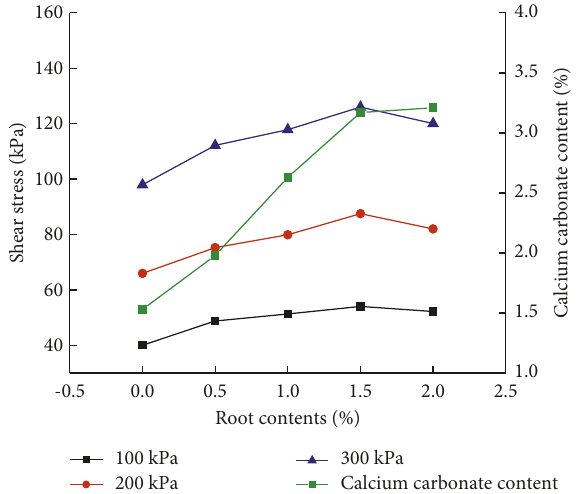
Figure 5: Relationship3 between shear strength, calcium carbonate content, and root content.